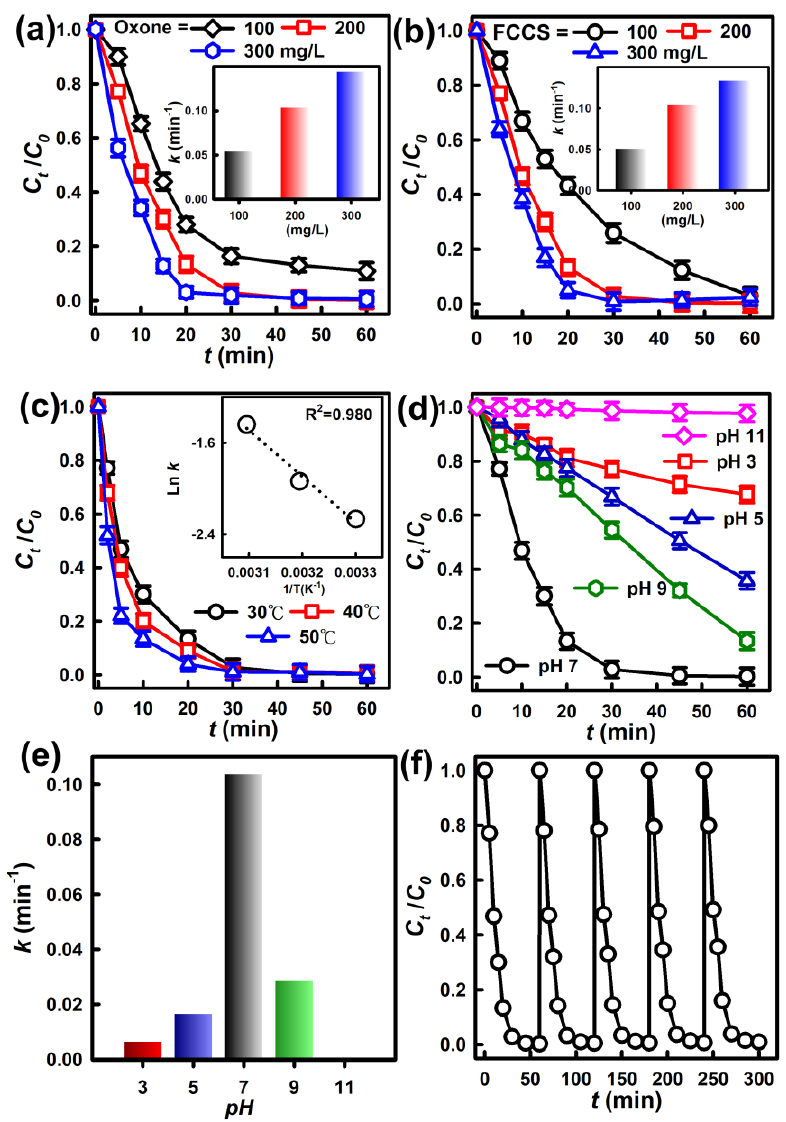
Figure 6. Effects of ( a ) catalyst, ( b ) Oxone, ( c ) temperature, ( d , e ) pH on AR degradation and ( f ) recy- clability (catalyst = 200 mg/L; Oxone = 200 mg/L; T = 30 ◦